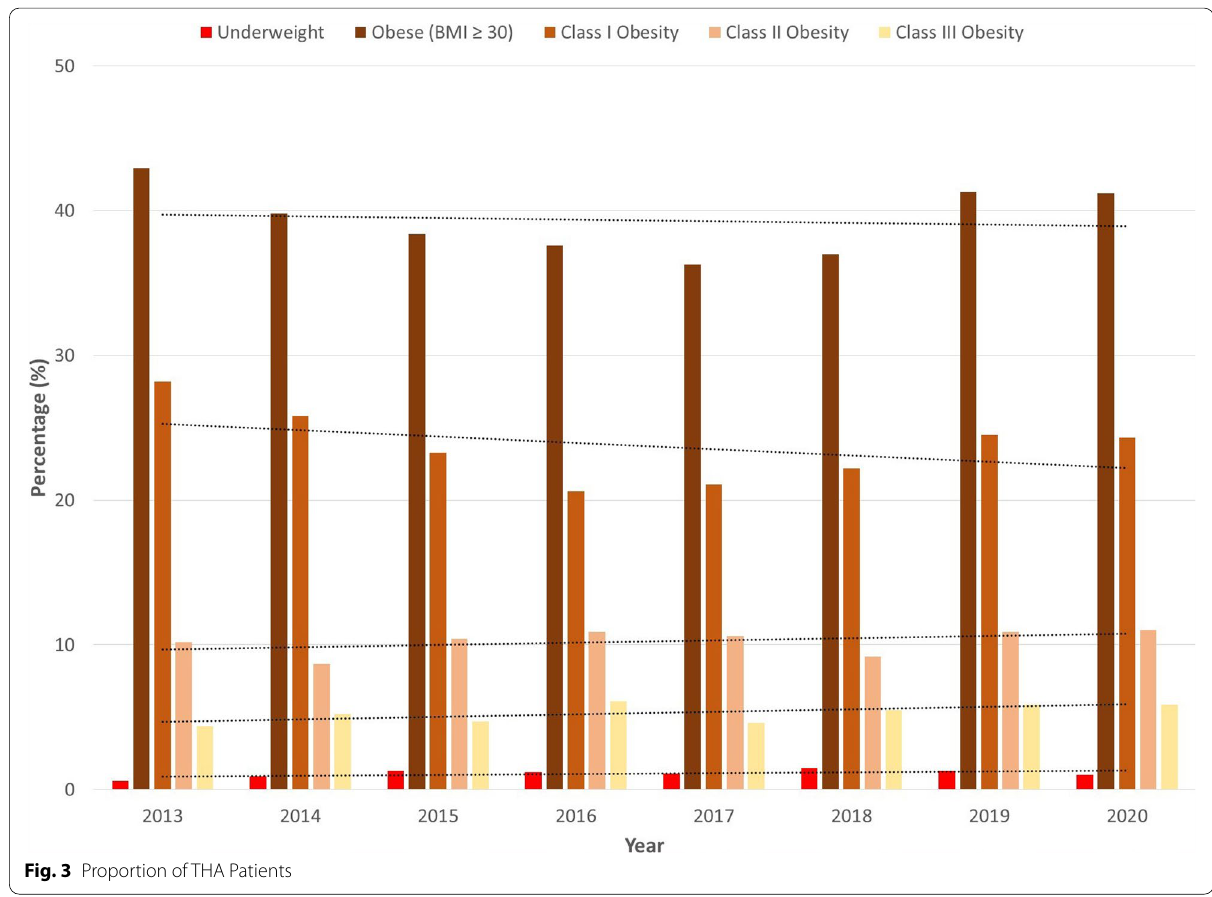
Fig. 3 Proportion of THA Patients